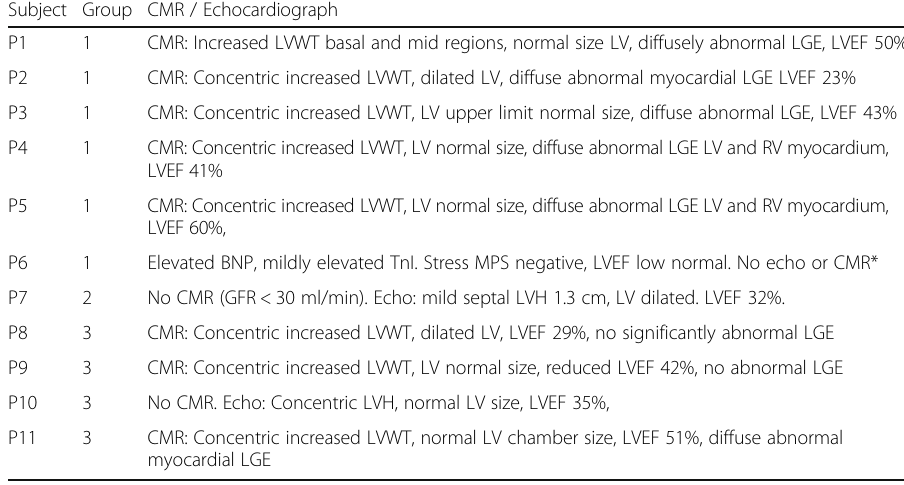
Table 2 Diagnostic CMR results for the patients with cardiac disease subdivided according to final diagnosis (*CMR not undertaken - see Table